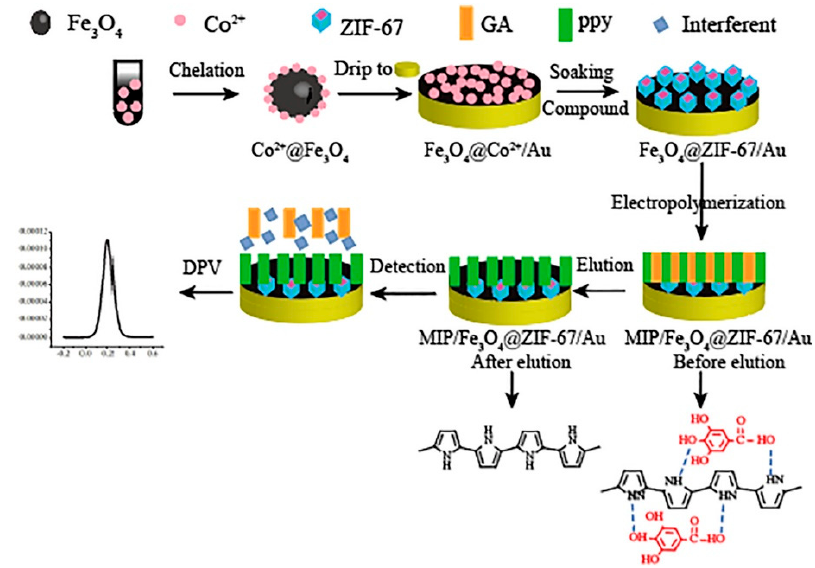
Figure 12. Fabrication of MIPpy / Fe 3 O 4 @ ZIF-67 / Au for electrochemical sensing of gallic acid by DPV. Reprinted from ref. [118] with permission of Elsevier.